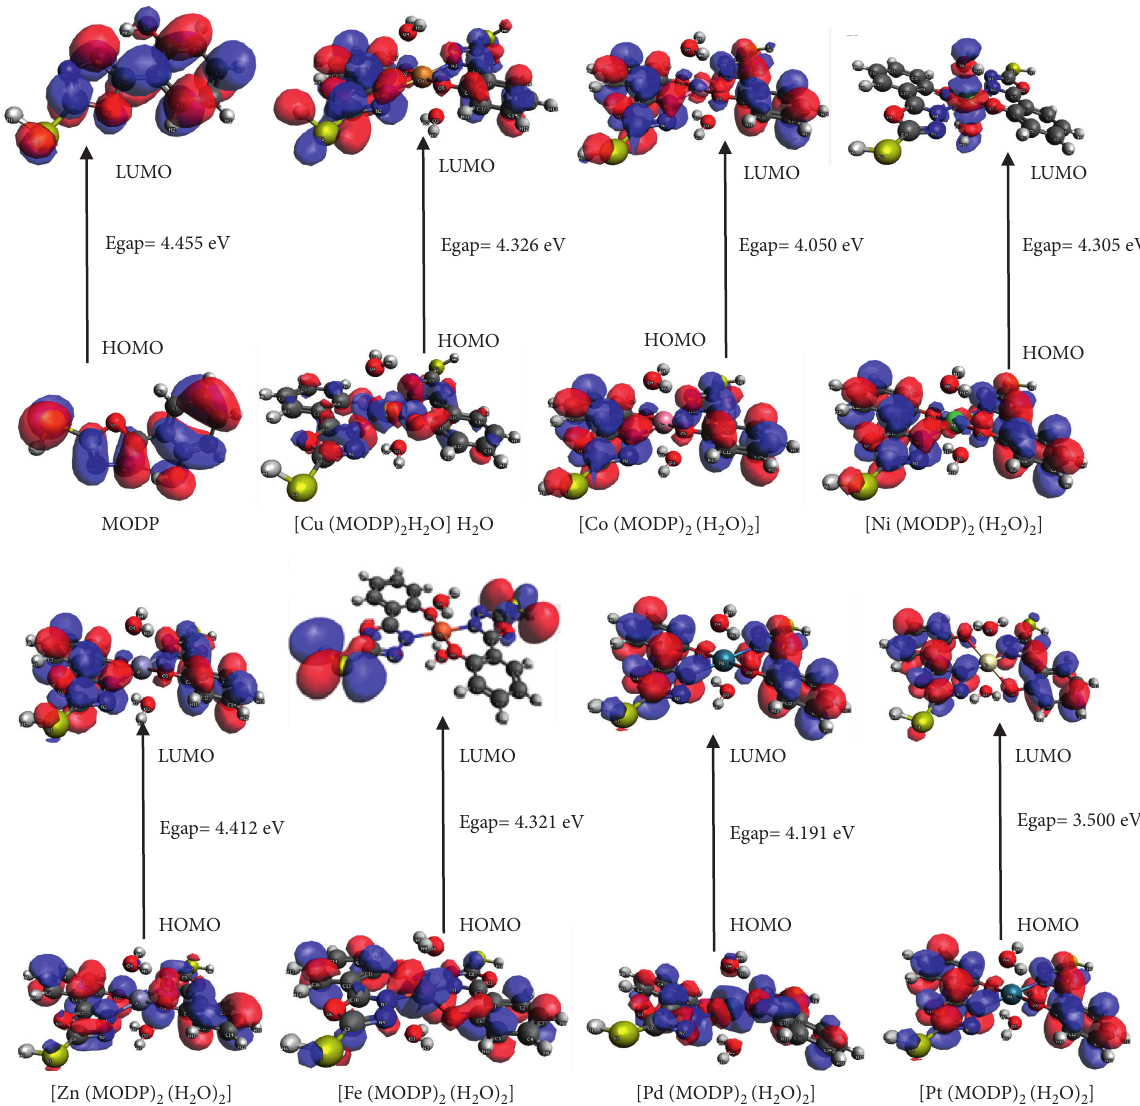
Figure 4: Isosurfaces of the FMOs of MODP and its complexes computed at PBE0-D3(BJ)/def2-TZVP level of theory in gas